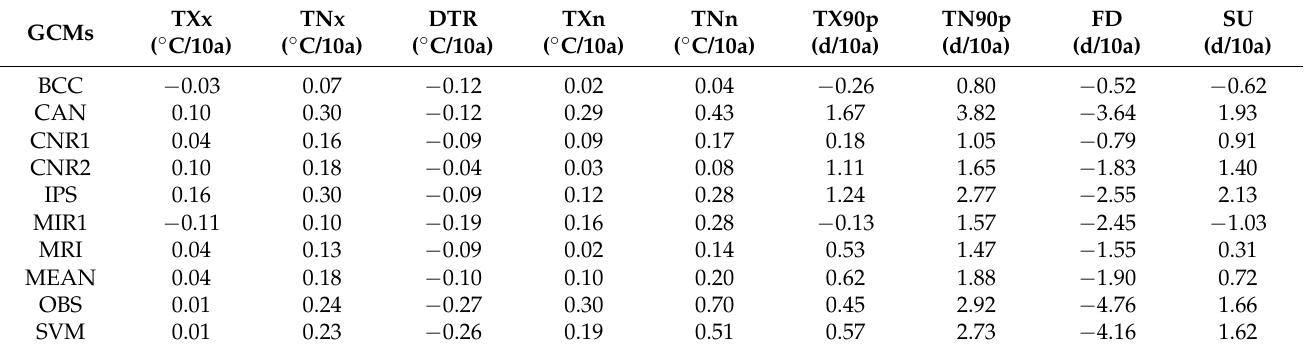
Table 4. Trends in nine extreme temperature indices in the North China Plain from 1961 to